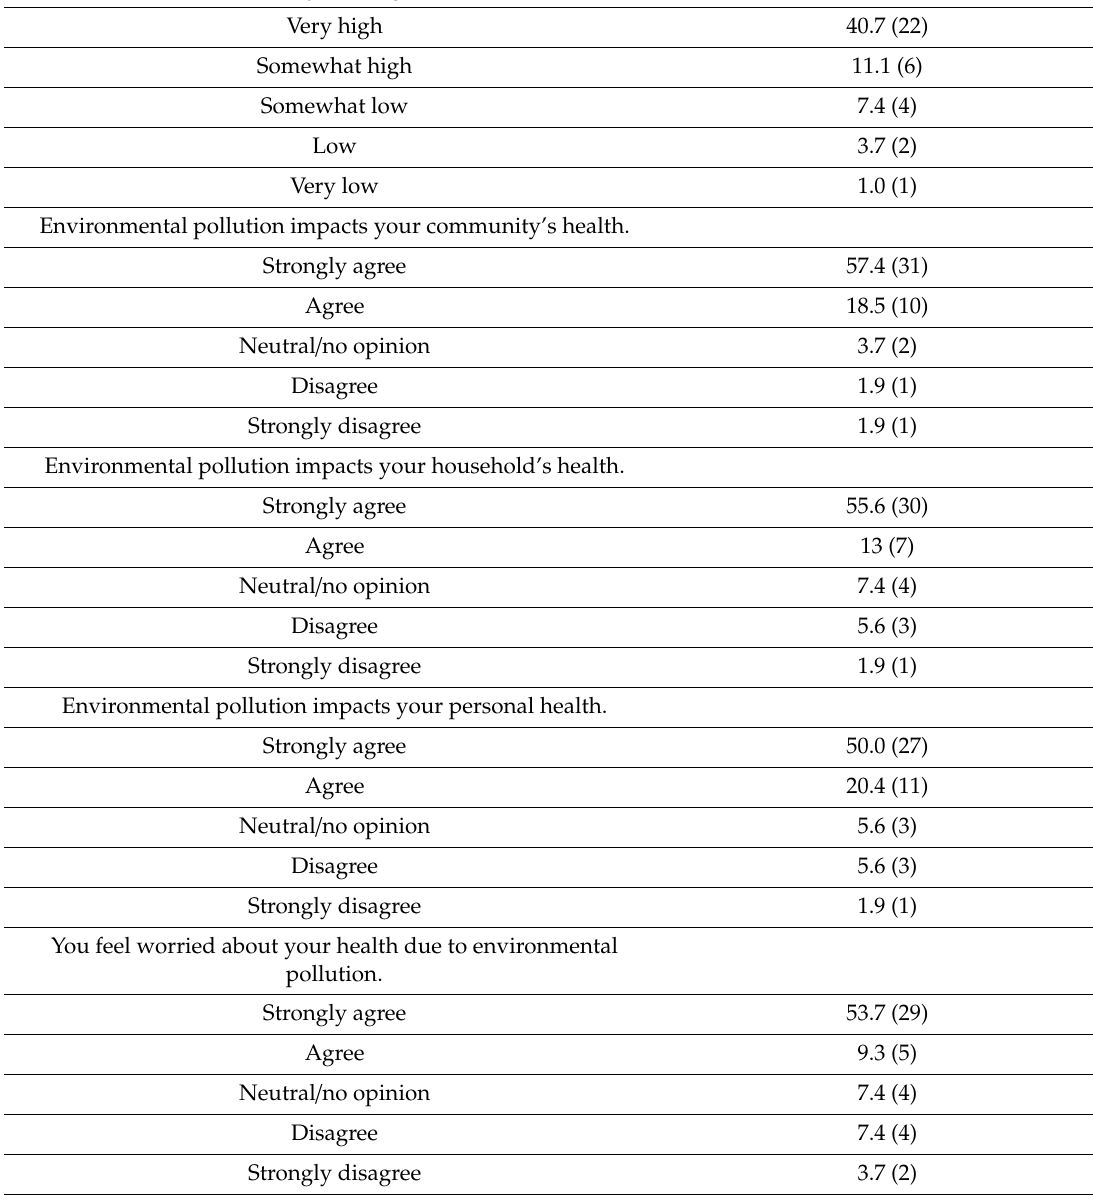
Table A1. Questions from the 86-item community health survey to identify residents’ environmental health concerns to inform subsequent environmental and biological sampling (n = 45). Question Percentage (Number of Respondents) How or low is the level of environmental pollution (i.e., air, water, land) in your neighborhood? Very high